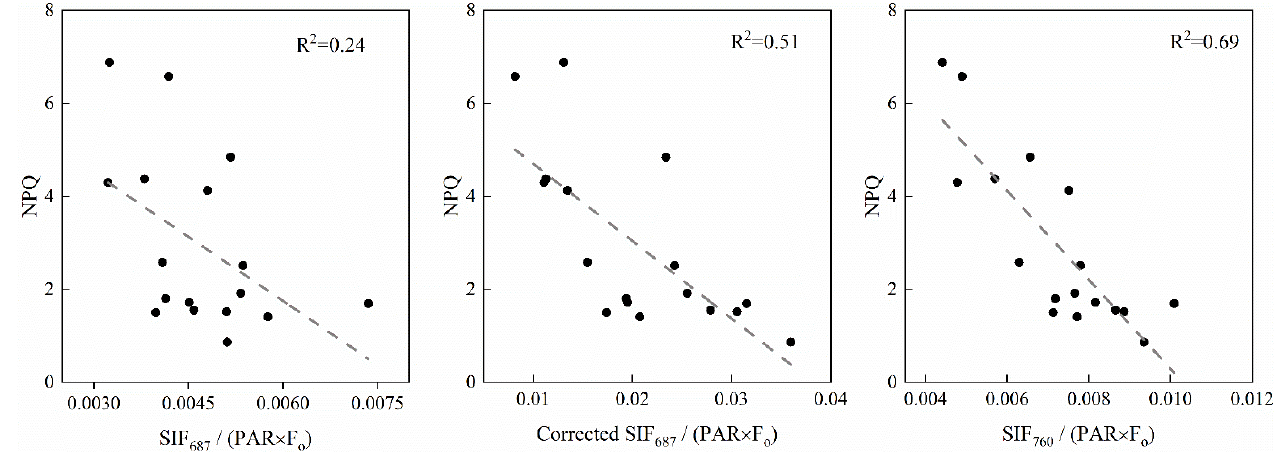
Figure 7. From left to right panel, relationship between the SIF yield at 687 nm before correction, SIF yield at 687 nm after correction and SIF yield at 760 nm and